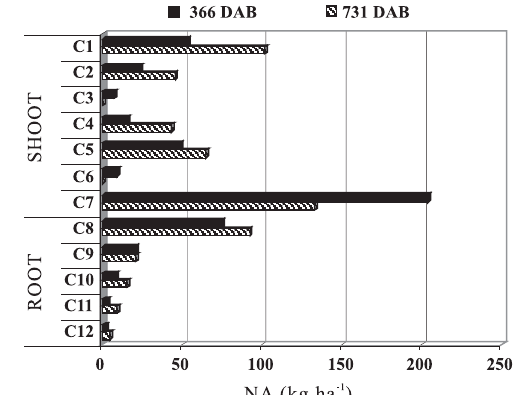
Figure 5. Shoot and root average accumulated total N (NA) distributions at the end of each to C are compartments of agricultural year. C 1 12 shoot and root, and DAB = days after beginning.